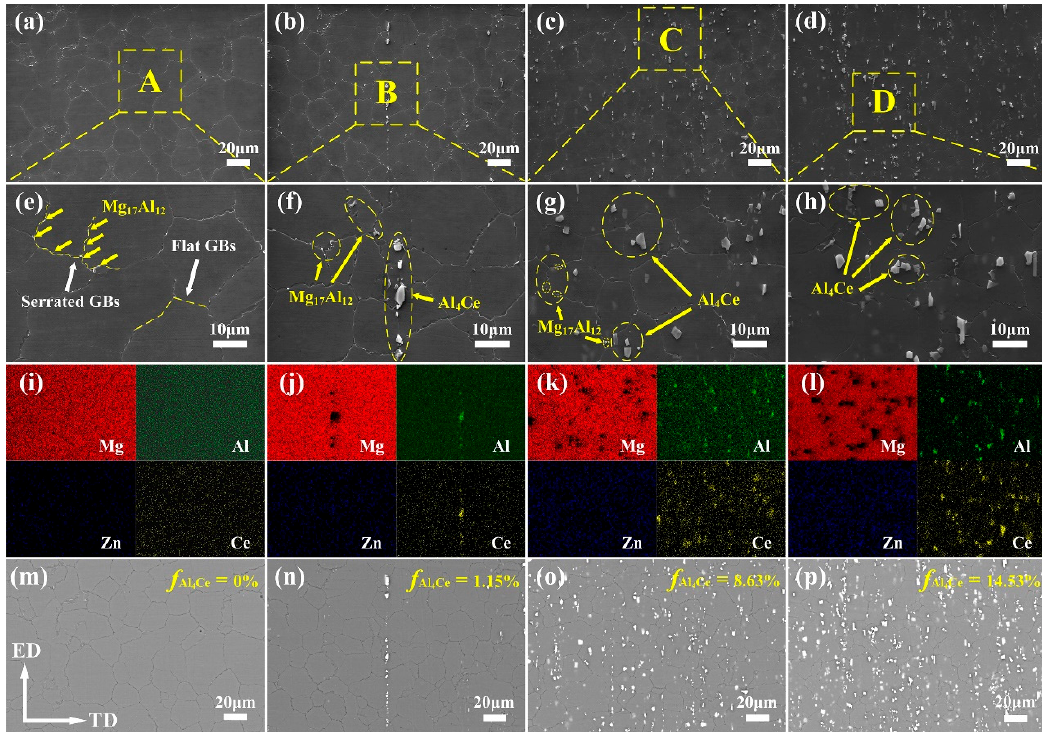
Figure 4. ( a–d ) Scanning electron microscope (SEM) micrographs of the as-extruded AZ80- x Ce alloys: ( a ) x = 0; ( b ) x = 0.2; ( c ) x = 0.8; ( d ) x = 1.4; ( e–h ) corresponding magnified SEM diagrams of the selected zone A, B, C, and D in ( a–d ), respectively; ( i–l ) corresponding energy dispersive spectrometer (EDS) mapping images of ( e–h ) (remark: each image contains four parts to show the different elements, Mg, Al, Zn, and Ce are marked in red, green, blue and yellow, respectively); ( m–p ) corresponding backscattered electron (BSE) micrographs of ( a-d ) (remark: f Al 4 Ce indicates the area fraction of Al 4 Ce phases).